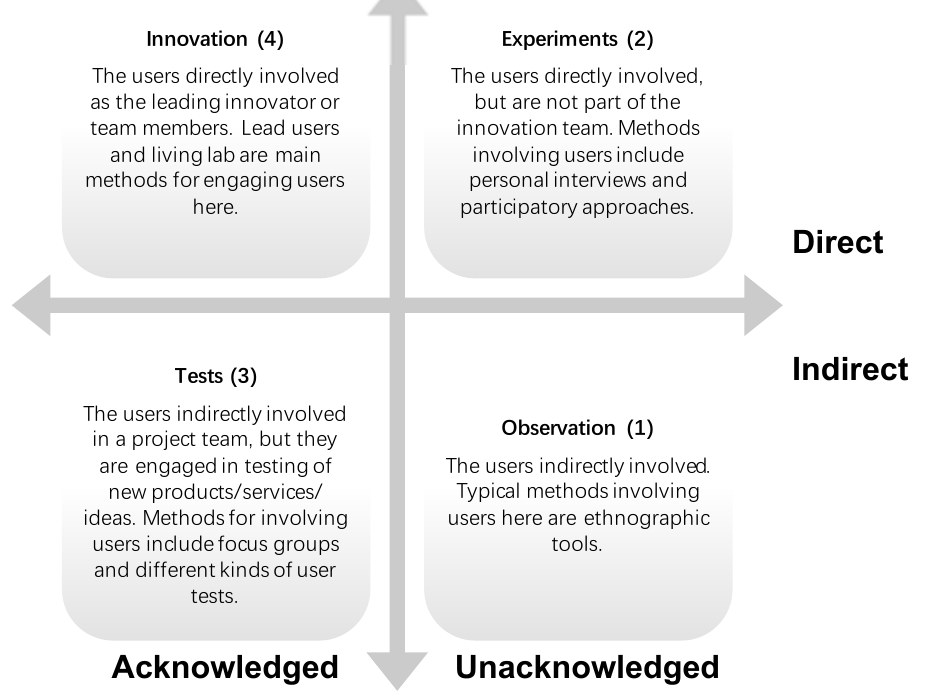
Fig. 2. Map of Users’ Roles in Innovation Process - Adapted from Røtnes and Staalesen